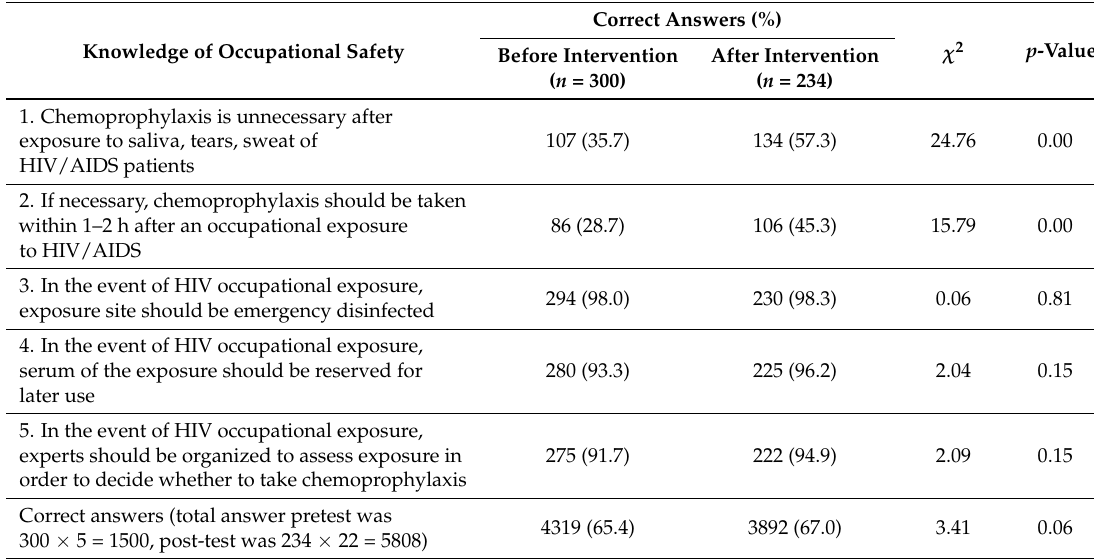
Table 7. Intervention effect on HIV post-exposure prophylaxis knowledge.